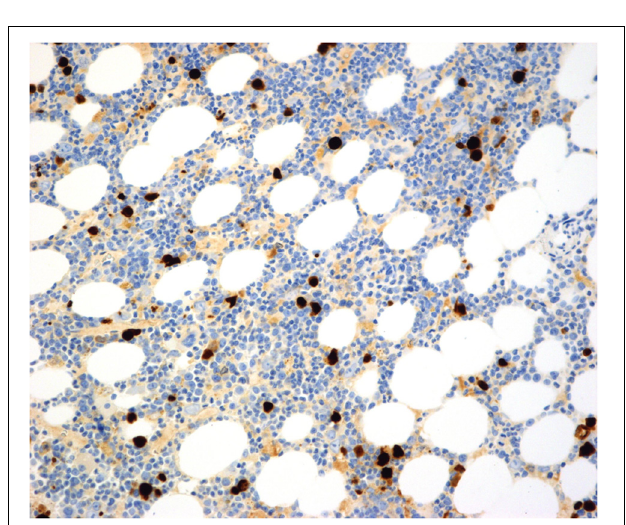
FIGURE 3 | Bone marrow biopsy at time of diagnosis. An immunohistochemical stain for parvovirus B19 highlights the infected